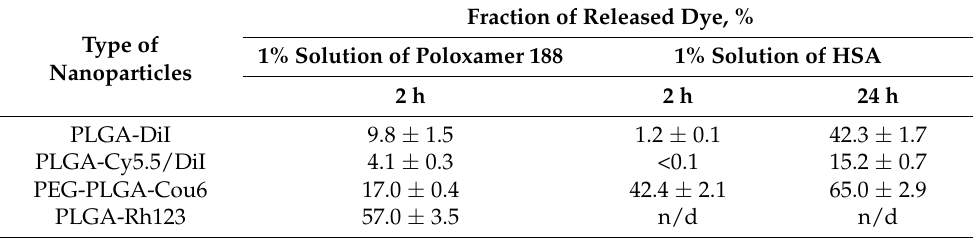
Table 1. Stability of labeling of the PLGA nanoparticles. In vitro release of DiI, Rh123, and Cou6 from PLGA nanoparticles (HSA, 1% solution in PBS, pH 7.4, 37 ◦ C, n = 3). Fraction of Released Dye, % Type of 1% Solution of Poloxamer 188 1% Solution of HSA Nanoparticles 2 h 2 h 24 h PLGA-DiI 9.8 ± 1.5 PLGA-Cy5.5/DiI 4.1 ± 0.3 <0.1 15.2 ± 0.7 PEG-PLGA-Cou6 17.0 ± 0.4 PLGA-Rh123 57.0 ± 3.5